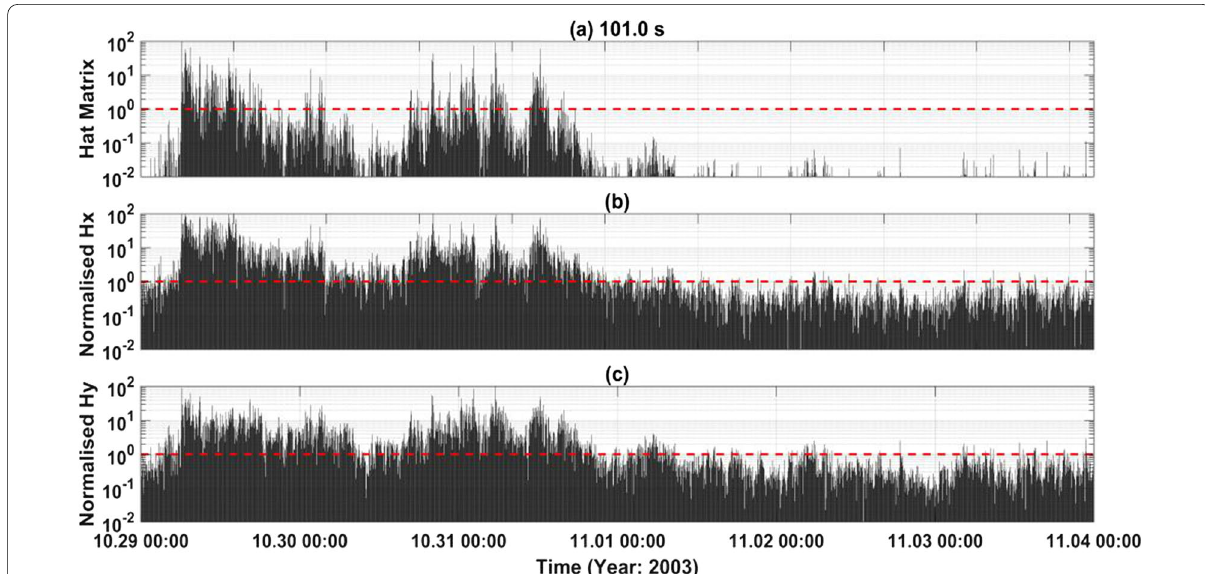
Fig. 4 Variations in the magnetic field amplitude and the hat matrix’s diagonal elements in the period of 101 s using the data observed at site 163 from 00:00 on October 29 to 00:00 on November 4. a Shows the hat matrix’s diagonal elements normalized by the expected value 2/ N . b , c Show the magnetic fields normalized by the standard deviation in the x- and y -directions, respectively. The variation in the hat matrix’s diagonal elements has the same trend as the magnetic field